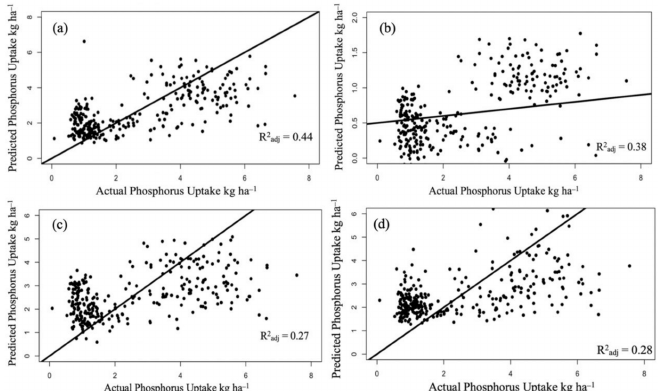
Figure 7. Relationship between the actual and predicted phosphorus uptake for ( a ) 1 July, the untransformed model; ( b ) 1 July, the transformed model; ( c ) 12 July, the untransformed model; ( d ) 1 August, the untransformed